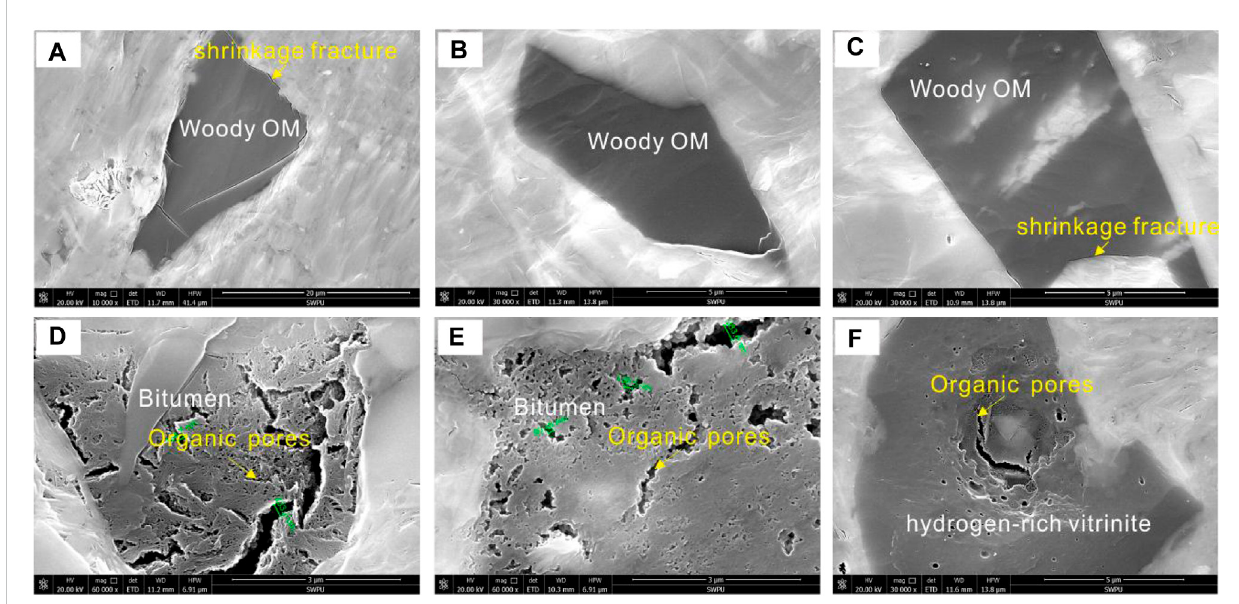
FIGURE 2 High-resolution SEM image of organic matters in Lianggaoshan Formation lacustrine shale reservoir. (A) No organic pores are developed in woody organicmatter(OM),TypeAshale,WellC,2455.06m; (B) Noorganicporesaredevelopedinwoodyorganicmatter(OM),TypeAshale,WellB,1896.13 m; (C) Only shrinkage fracture areobervedattheedgeofwoodyorganic matter(OM), Type Bshale,Well C,2452.29m; (D) Organicporesinbitumen,TypeB shale, Well A, 1751.71 m; (E) Organic pores in bitumen, Type C shale, Well C, 2465.48m; (F) Organic pores in hydrogen-rich vitrinite, Type C shale, Well B, 1928.58